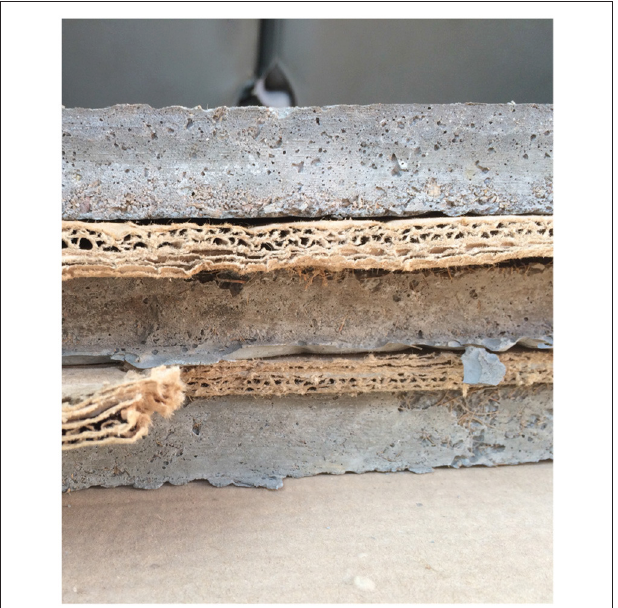
FIGURE 4 | Fiber cement composite panels